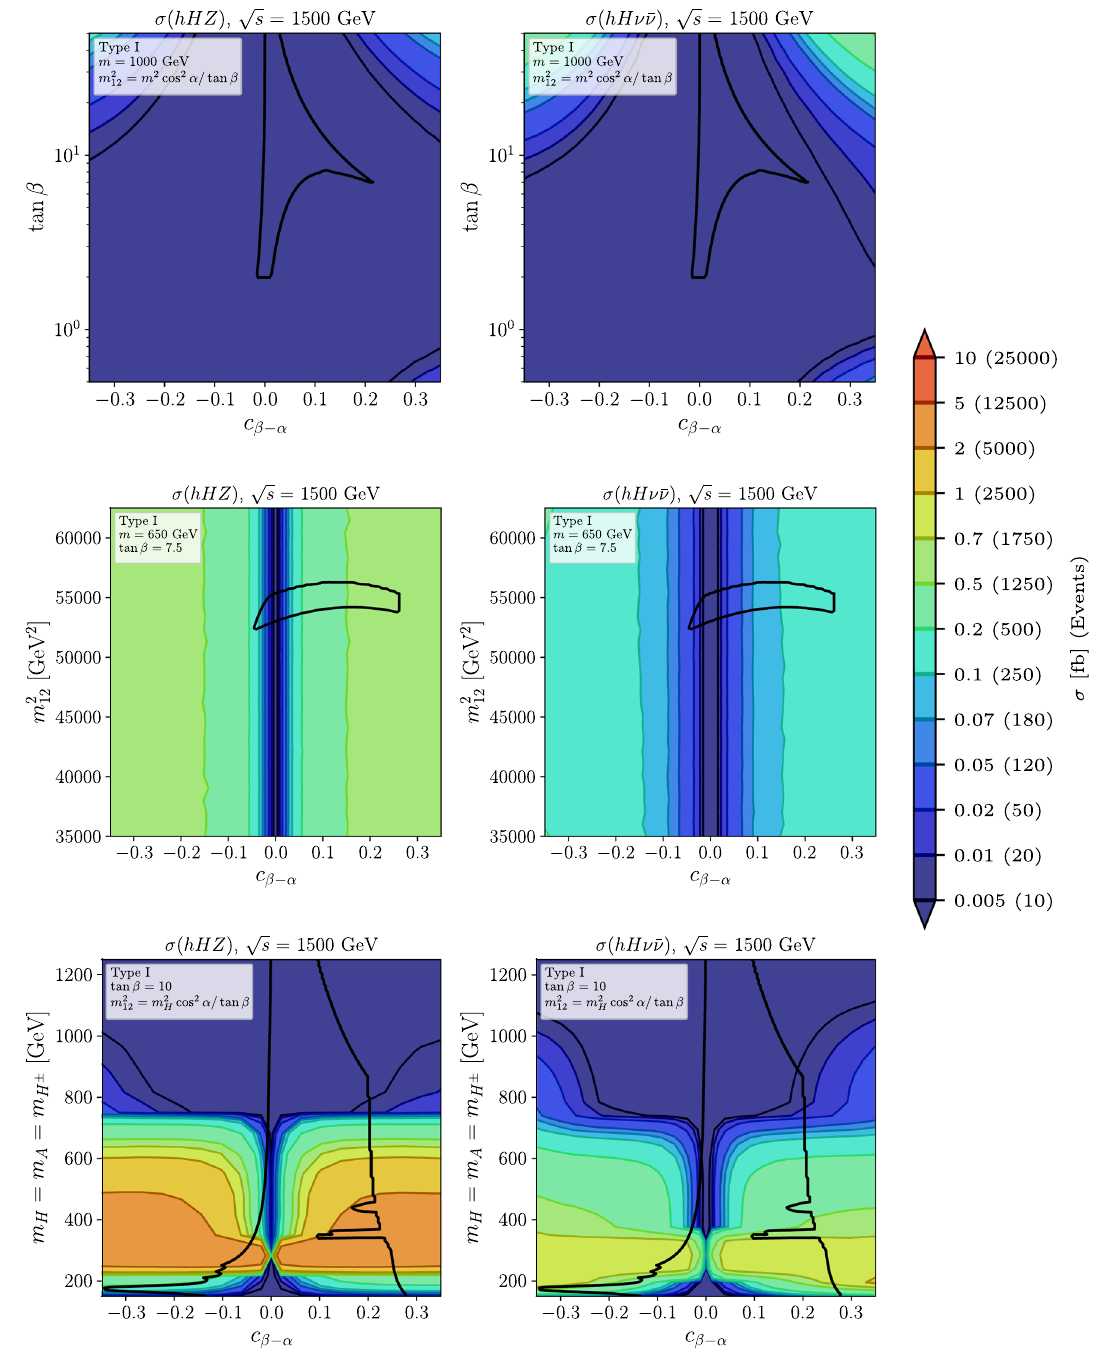
√ s = 1500 GeV for the benchmark planes 1-3 (top to bottom).